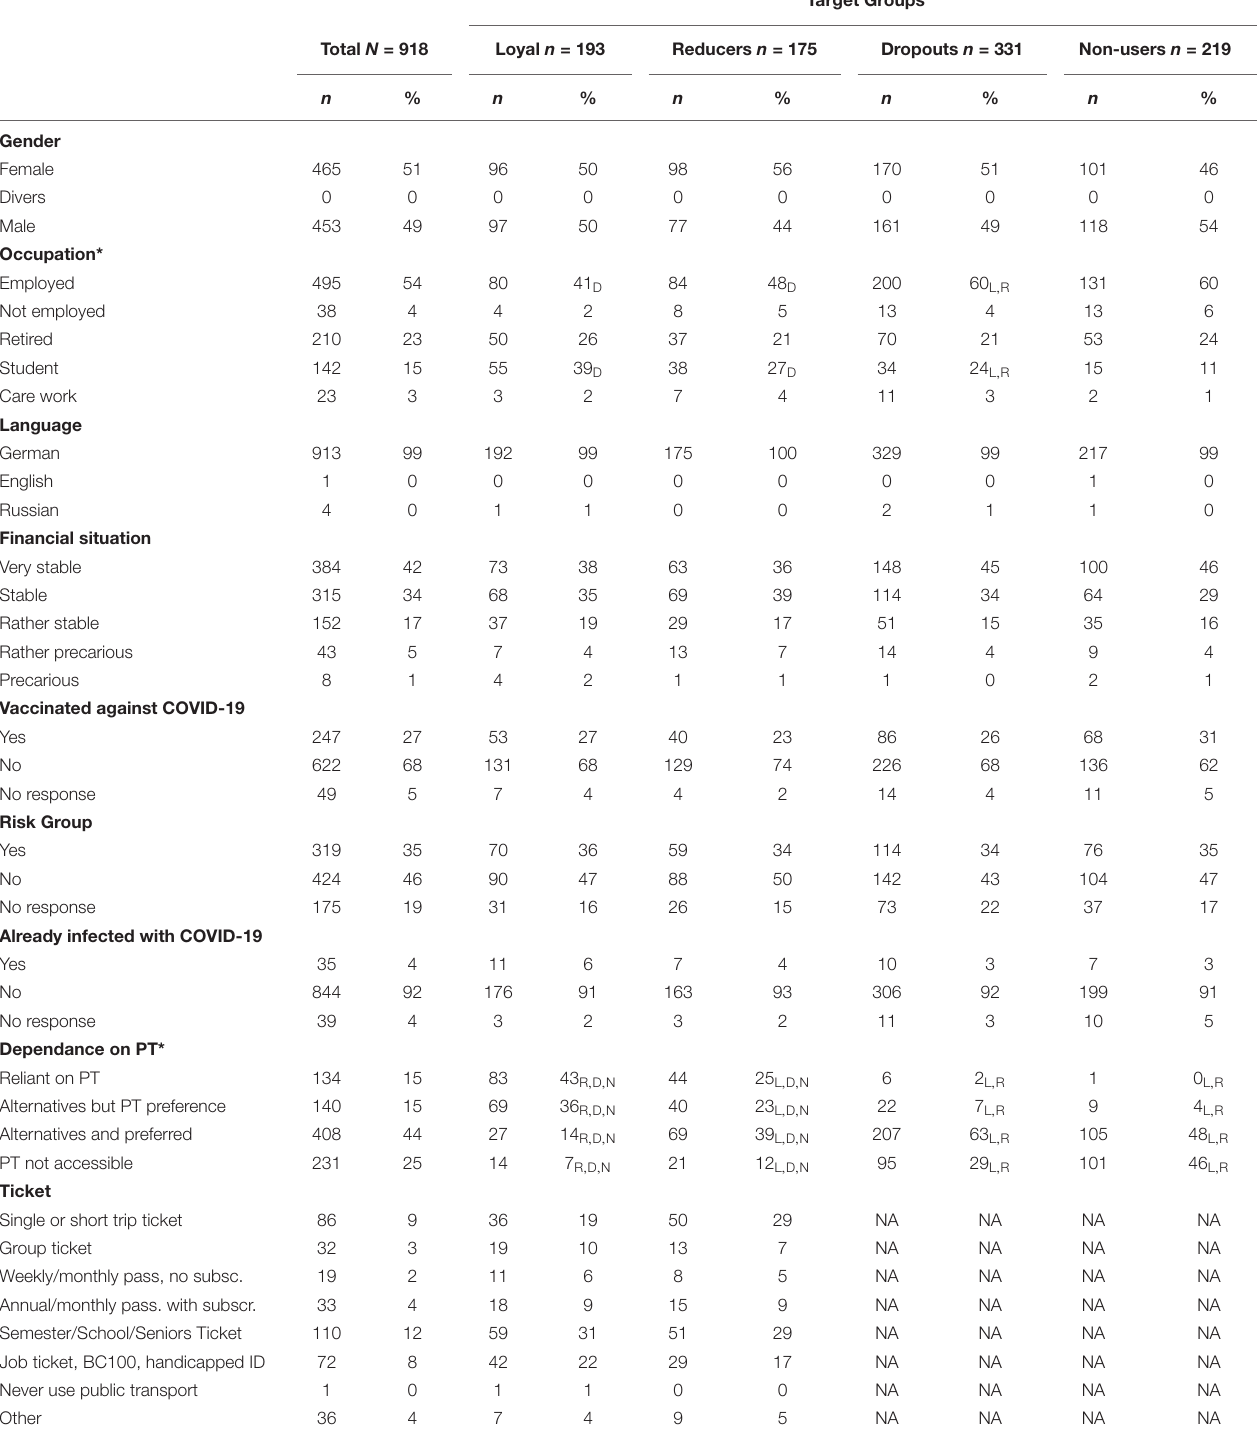
TABLE 1 | Sociodemographic characteristics of